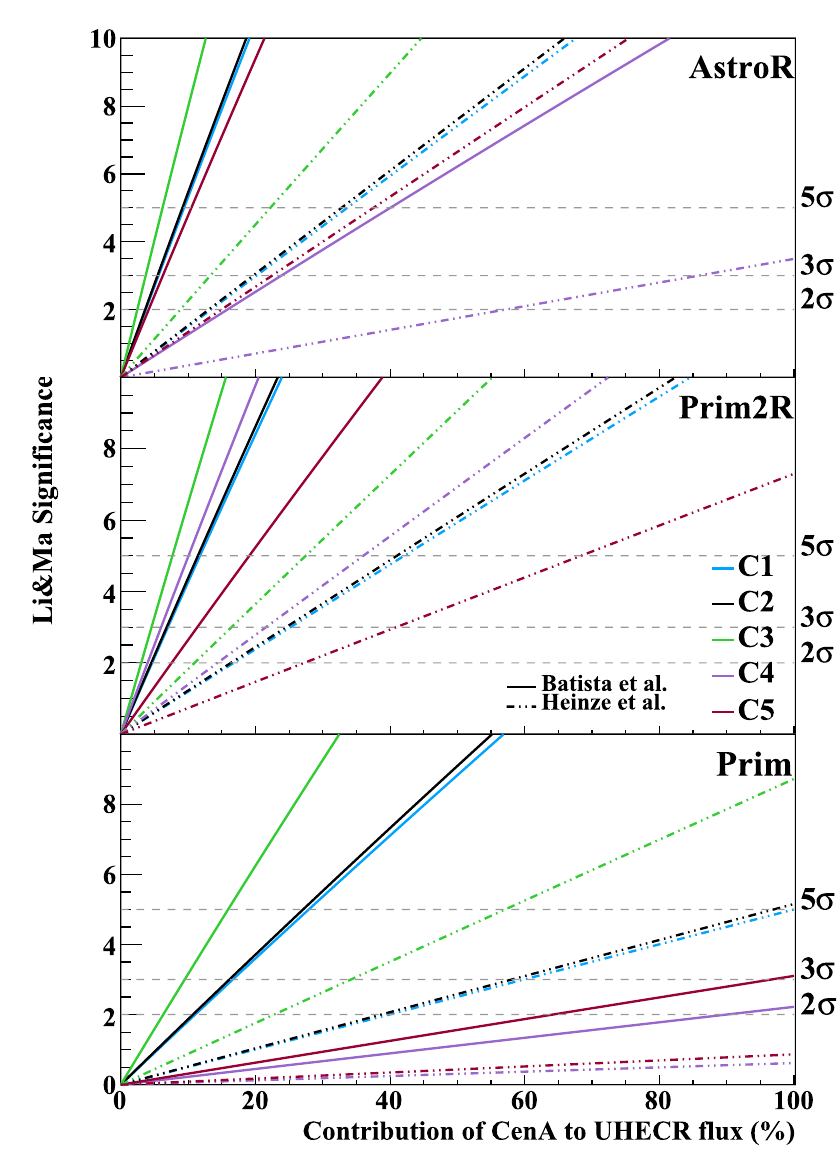
Fig. 7 Li-Ma significance of the secondary neutrino signal as a function of the contribution from Cen A to the total UHECR flux measured by the Pierre Auger Observatory for energies above 60 EeV. The significance was calculated supposing 200,000 km 2 detection area observatory taking data during one year. Full (dashed-dotted) lines represents the calculations when cosmogenic background neutrinos were estimated according to Batista et al. [23] (Heinze et al. [24]) and considered as the null hypothesis. The three EGMF models (AstroR, Prim2R and Prim) and five composition abundance (C1–C5) are